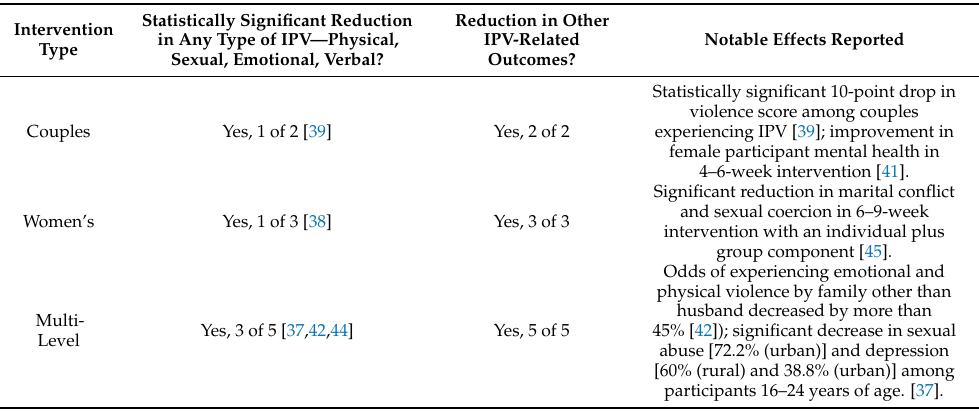
Table 3. Intervention types and notable effects